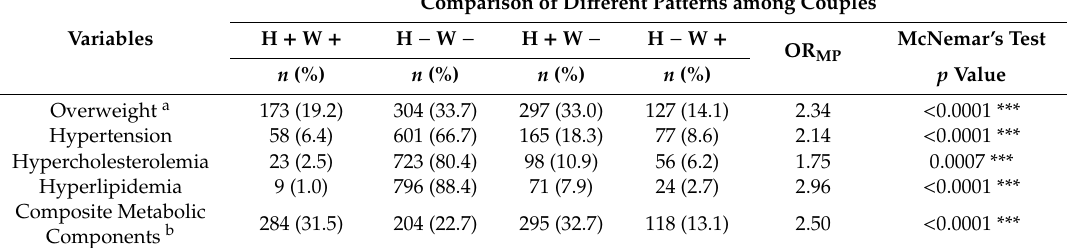
Table 3. Spousal concordance in metabolic components, and comparisons among di ff erent patterns ( n = 901